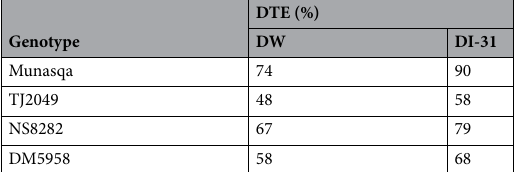
Table 2. Drought Tolerance Efficiency (DTE) of four commercial soybean cultivars foliarly sprayed with distilled water or DI-31 every 21 days and submitted to a 10–day drought period at the R 5 critical stage. DTE calculations were based on the absolute yield per plant